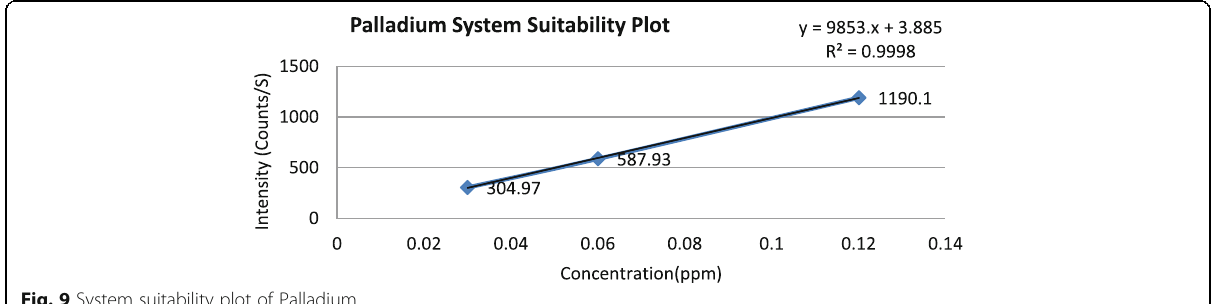
Fig. 9 System suitability plot of Palladium